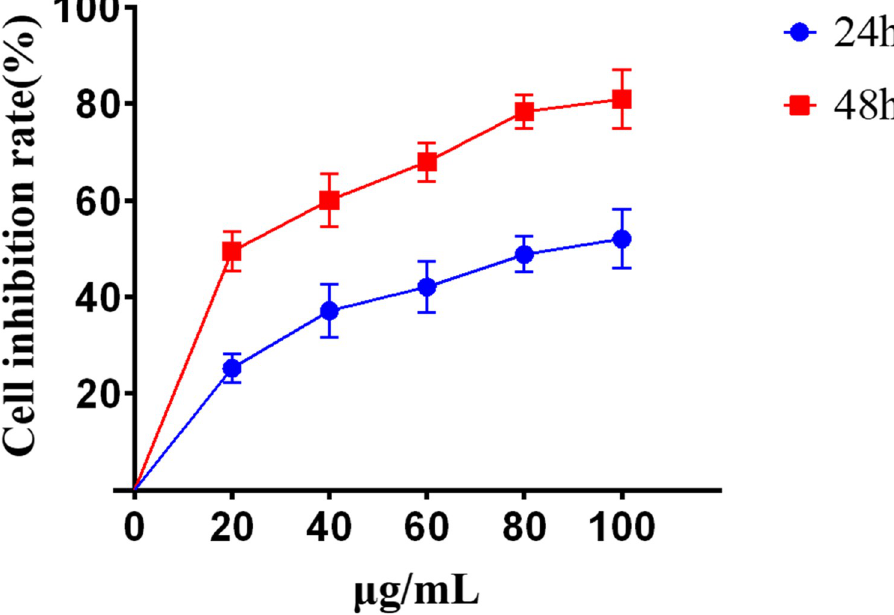
Fig 3. Inhibition rates of lingonberry extracts on proliferation of HepG2 cells treated for 24 h and 48 h.